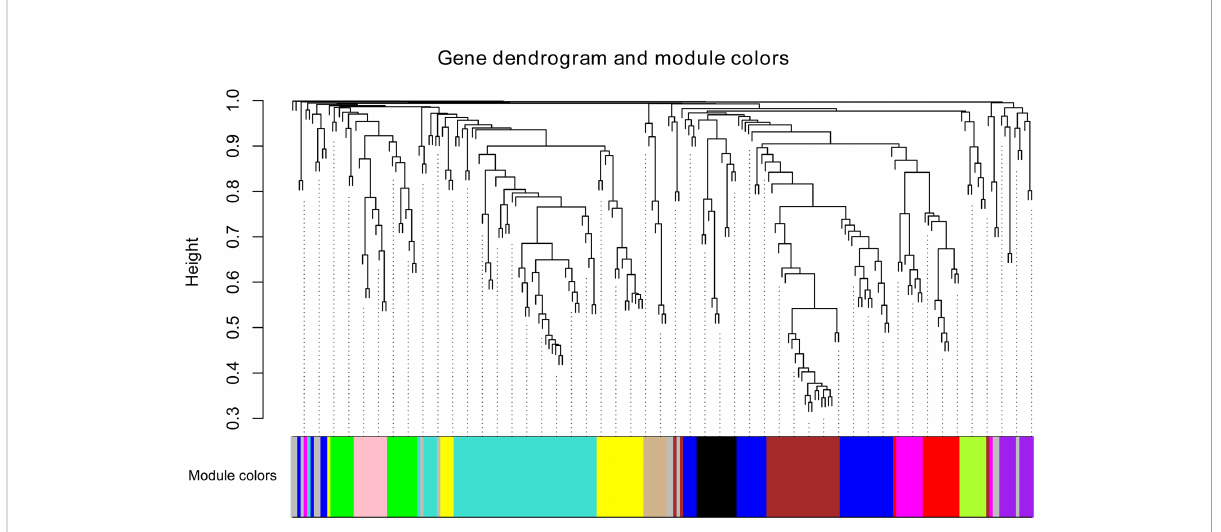
FIGURE 8 The co-expression network between lncRNAs and fl oral scent compounds. Clustering dendrogram of lncRNA and fl oral scent compounds, with dissimilarity based on the topological overlap, together with assigned module colors. Module colors are assigned according to module size, and the color gray is reserved for non-module lncRNAs.